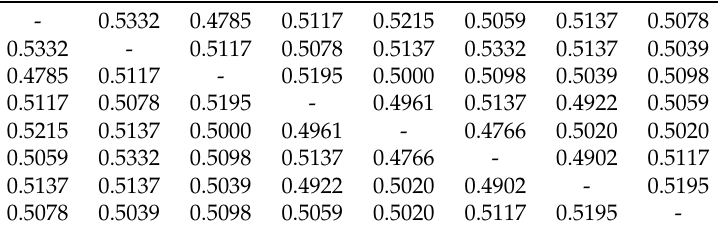
Table 7. The BIC-SAC analysis of our S-box.